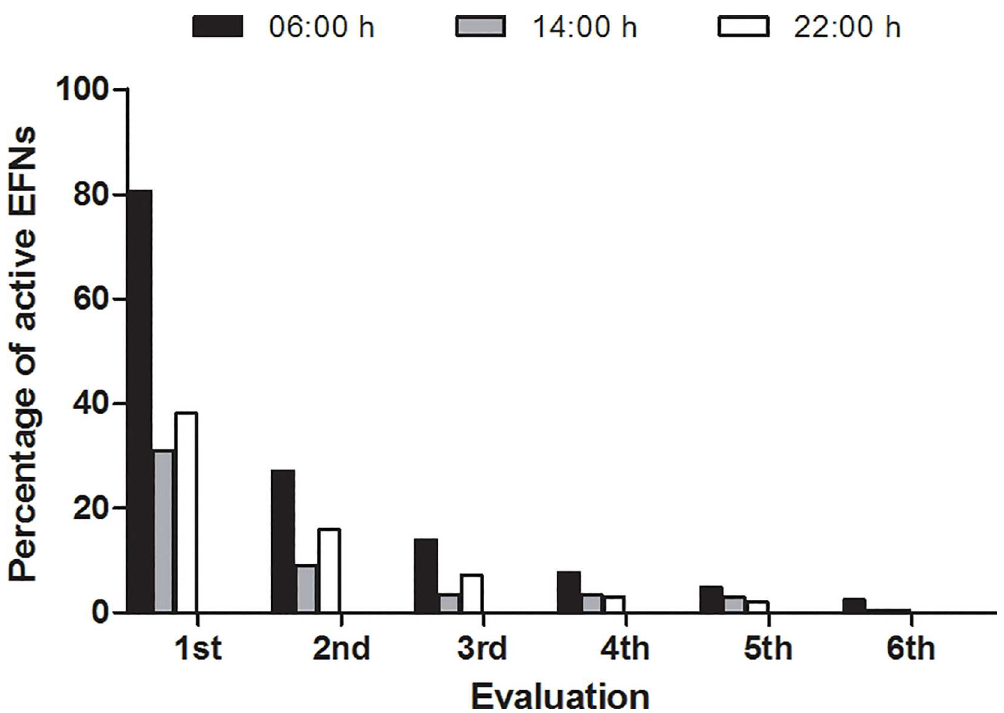
Fig 4. Percentage of active EFNs (n = 210 EFNs) in the group of plant species (n = 7 species) assessedat three distinct times of the day since the beginning of their activity up to their necrosis (n = 6 observations).